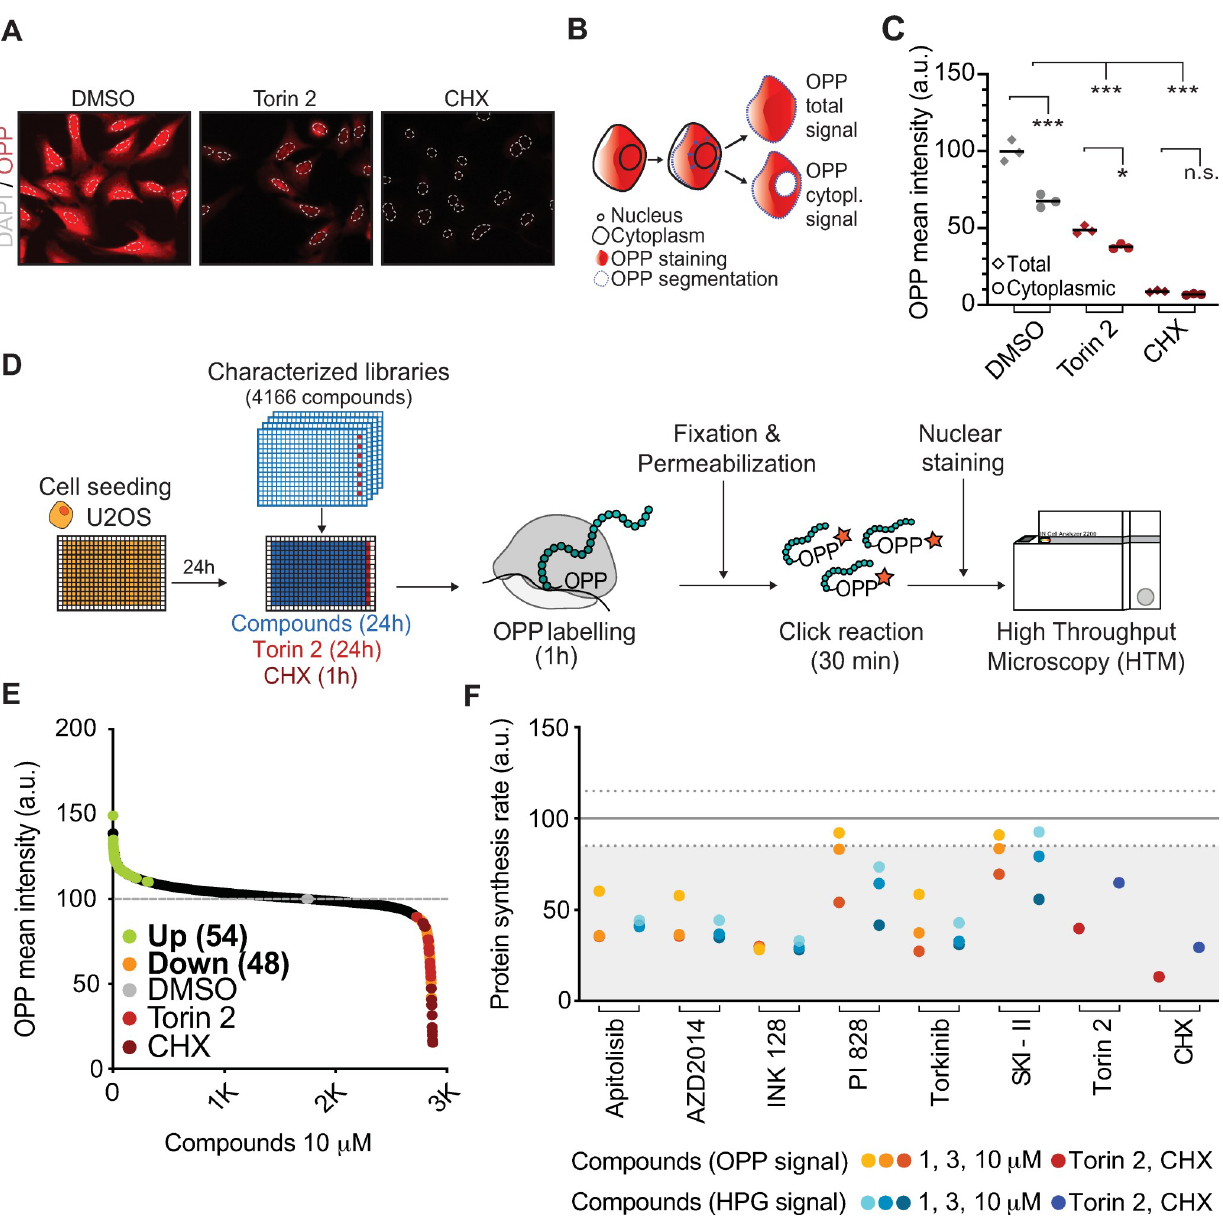
Fig 1. A chemical screen for modulators of protein synthesis. (A) OPP incorporation (RED) in U2OS cells exposed to the mTORC1 inhibitor Torin 2 (0.5 μ M, 3 h) or CHX (100 μ g/mL, 30 min). Nuclei were stained with Hoechst (outlined with a dashed GRAY line). (B) Scheme illustrating the strategy for the quantification of the cytoplasmic OPP signal. (C) HTM-mediated quantification of OPP-associated total and cytoplasmic signal in U2OS cells exposed to Torin 2 and CHX, as in (A). ��� p < 0.001. Data C in S1 Data. (D) Schematic overview of the phenotypic screen workflow. U2OS cells were plated in 384-well plates. On the next day, cells were exposed to compounds at 10 μ M or 0.5 μ M of Torin 2 in specific wells (RED) as a control. After 23 h, CHX (100 μ g/mL) was added for an hour in specific wells as an additional control (DARK RED). Then, all wells were pulsed with OPP for an hour, after which cells were fixed and processed for HTM-dependent quantification of the OPP signal and nuclei counts. (E) Compound distribution from the screen described above. Compounds increasing (up-regulators, GREEN) or decreasing (down-regulators, ORANGE) OPP incorporation over 3 standard deviations compared to the DMSO control (GRAY) are shown. Compounds exceeding 30% toxicity were excluded from this analysis. Data E in S1 Data. (F) Dose response (1, 3, and 10 μ M) of 6 compounds down-regulating translation in U2OS cells after a 24-h exposure. Controls Torin 2 (0.5 μ M, 24 h) and CHX (100 μ g/mL, 1 h) are shown. Hit validation was conducted by measuring OPP (ORANGE) or HPG (BLUE) incorporation assays. Data F in S1 Data. CHX, cycloheximide; DMSO, dimethyl sulfoxide; HPG, homopropargylglycine; HTM, high-throughput microscopy; mTORC1, mechanistic target of rapamycin complex 1; OPP,